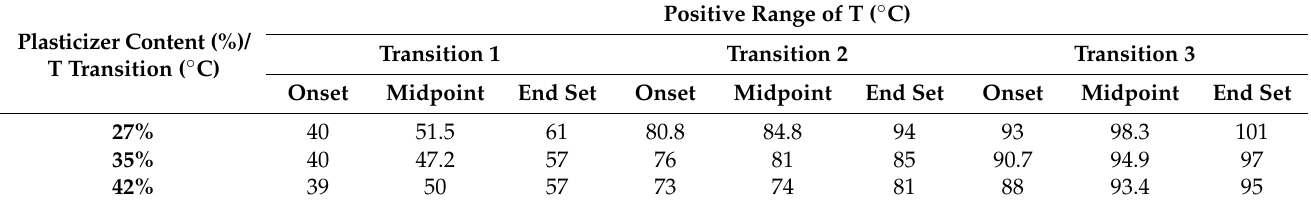
Table 3. The glass transitions of the plasticized starch-PVOH blends between 39 ◦ C and 101 ◦ C.